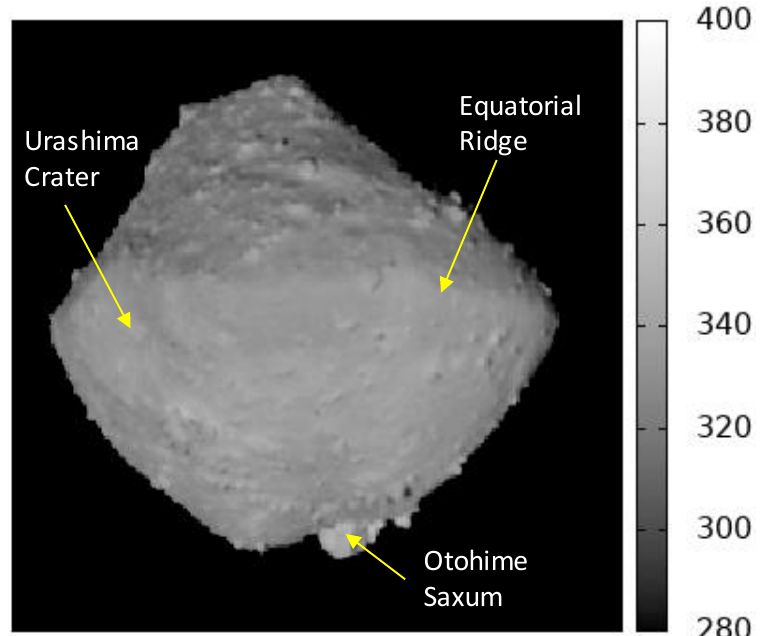
Figure 4. Thermal image of Ryugu taken by TIR on 1 August 2018 from the Mid-Altitude (5 km from Ryugu), with the spatial resolution of 4.5 m per pixel. The largest crater Urashima is observed at the equator, and the largest boulder Otohime is seen at the South Pole. Boulders larger than 20 m are all identified in this image set, showing almost the same temperature with the surroundings. The temperature scale is in Kelvin. (Image: hyb2_tir_20180801_152032_l2.fit, © JAXA).